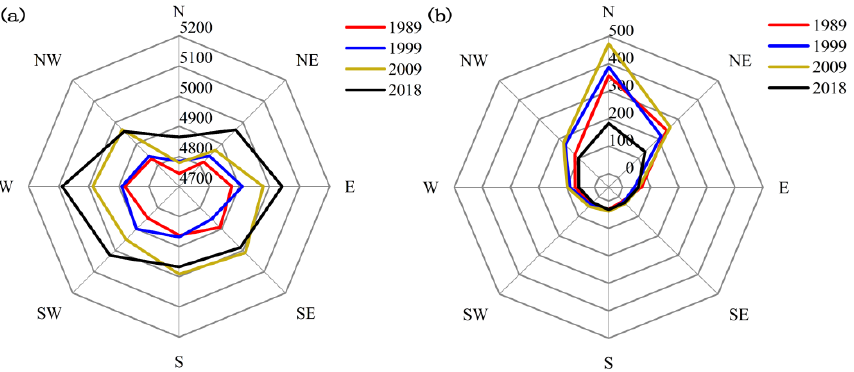
Figure 9. Glacier SLA ( a ) and number of glaciers with different orientations ( b ) in the Qilian Mountains in 1989, 1999, 2009 and 2018.